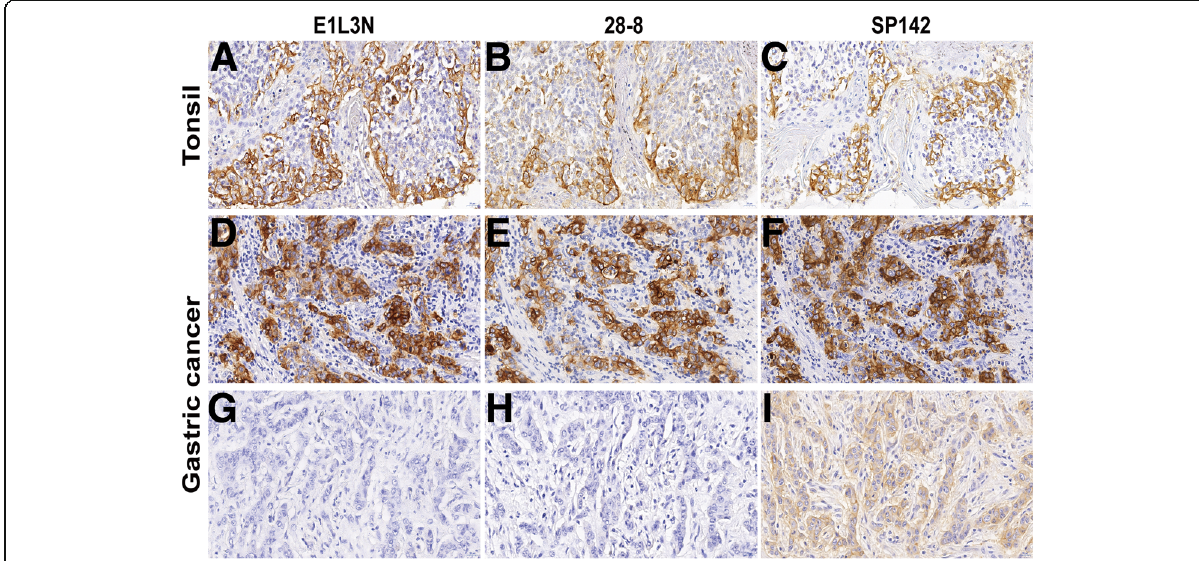
Fig. 1 Representative photomicrographs of PD-L1 expression in tonsil tissue and GC. All three antibodies (clone SP142, 28 – 8 and E1L3N) showed a similar, predominantly membrane staining pattern in tonsil tissues ( a - c ) and GC ( d - f ). One specimen showed weak positive staining for clone SP142, but negative staining for clones 28 – 8 and E1L3N ( g - i ). The original magnification of all images is 400×. GC, gastric cancer;